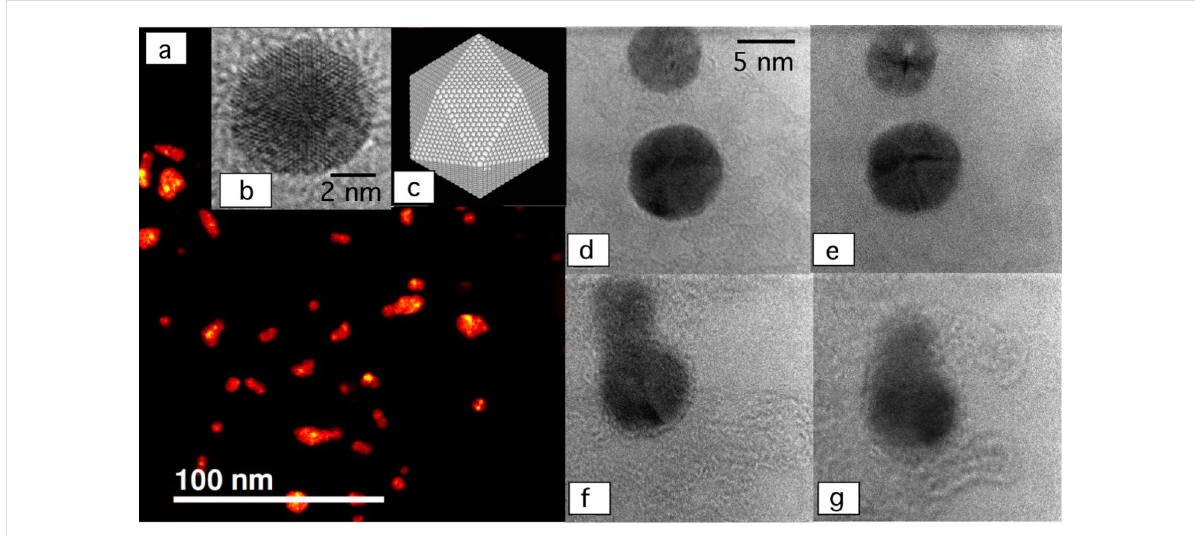
Figure 2: (a) STEM–HAADF image of Ag NPs, (b) atomically resolved TEM image of a single NP, revealing crystallite multitwinning corresponding to a McKay icosahedral geometry, (c) atomistic model of a NP with a McKay icosahedral geometry, and (d–g) sequence of TEM images taken at time intervals t ≈ 60 s, showing diffusion and aggregation of two Ag